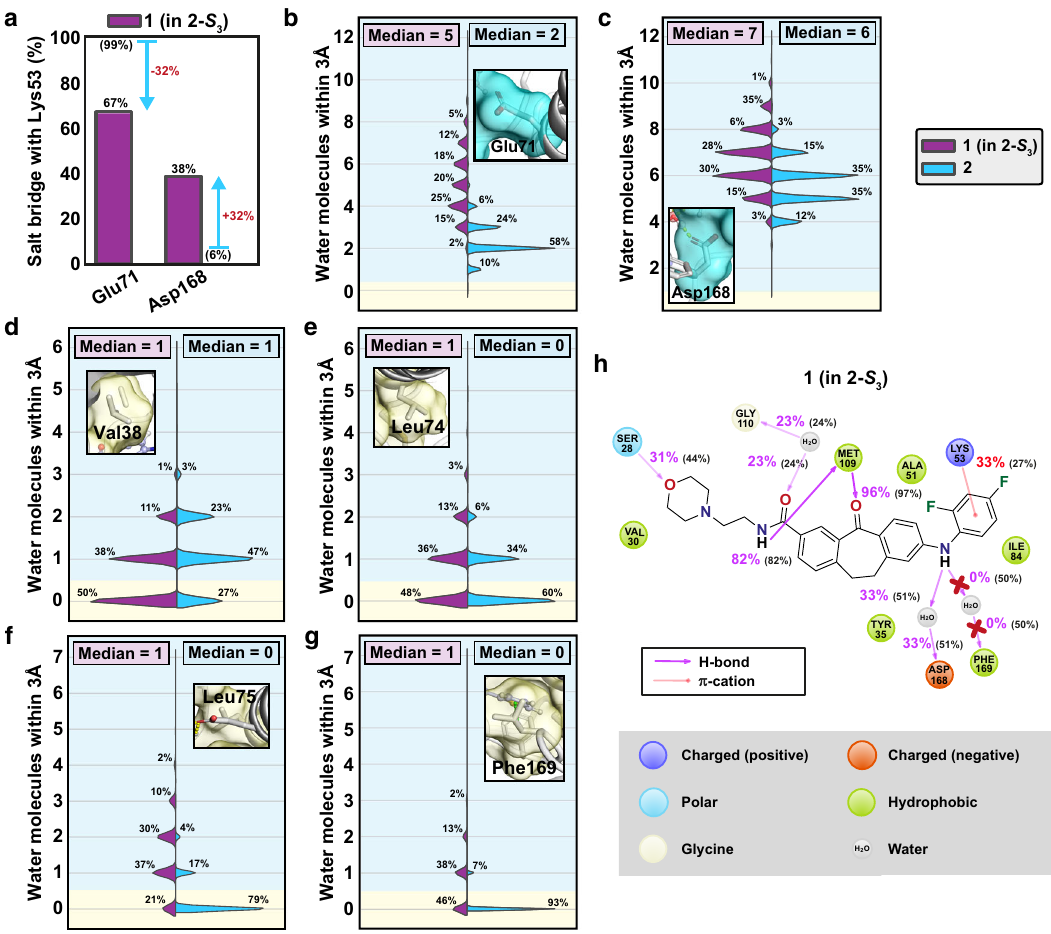
Fig. 6 Changing the bound ligand in p38 α MAPK – 2 to 1 disrupts the stability of the kinase. a Salt bridge pro fi le of Lys53 with 1 in 2- S 3 is shifted towards the pro fi le which is observed for p38 α MAPK- 1 . Salt bridge interactions observed in simulations of 2 are shown in parenthesis and the differences are indicated with blue arrows. Solvent exposure of the salt bridge forming residues Glu71 ( b ) and Asp168 ( c ). Solvent exposure of the hydrophobic residues Val38 ( d ), Leu74 ( e ), Leu75 ( f ), and Phe169 ( g ). In b - g the blue background indicates solvent exposure (where ≥ 1 water molecule is located within 3 Å of the side chain) and the yellow background indicates when the side chain is not exposed to solvent. h Interactions for 1 when bound in 2- S 3 conformation. The inhibitor loses its key water mediated interactions to Phe169 and interactions to Asp168 are diminished. In parenthesis are the interaction frequencies observed for 1 in its preferred p38 α MAPK binding conformation (Fig. 1d). Simulation data was analysed for each 1 ns i.e. data in a – d consist of 90,120 and 86,505 individual data points for 1 in 2- S 3 and 2 , respectively. Source data are provided as a Source Data fi le.